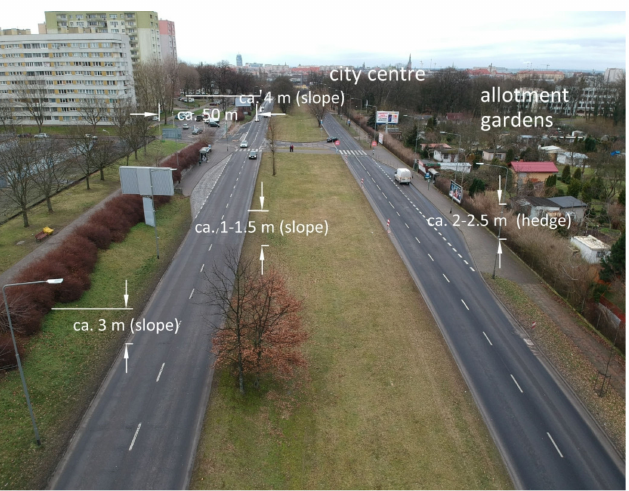
Figure 3. Local topography of the study area (bird’s-eye view of the analysed section of the street viewing towards the city